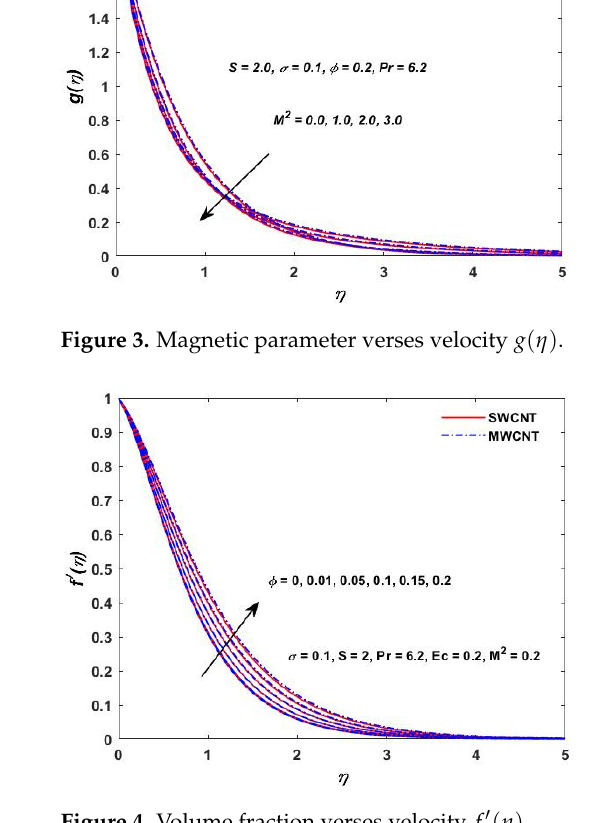
Figure 4. Volume fraction verses velocity 𝑓 (cid:4593) (𝜂).